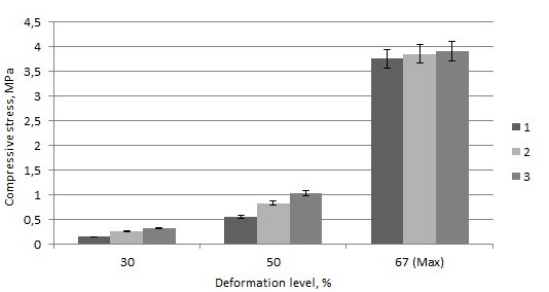
Figure 2. Variation in compressive stress with polymer binder’s (- NCO 2.4 %) content (1- 13 wt.%; 2-18 wt.%; 3- 23